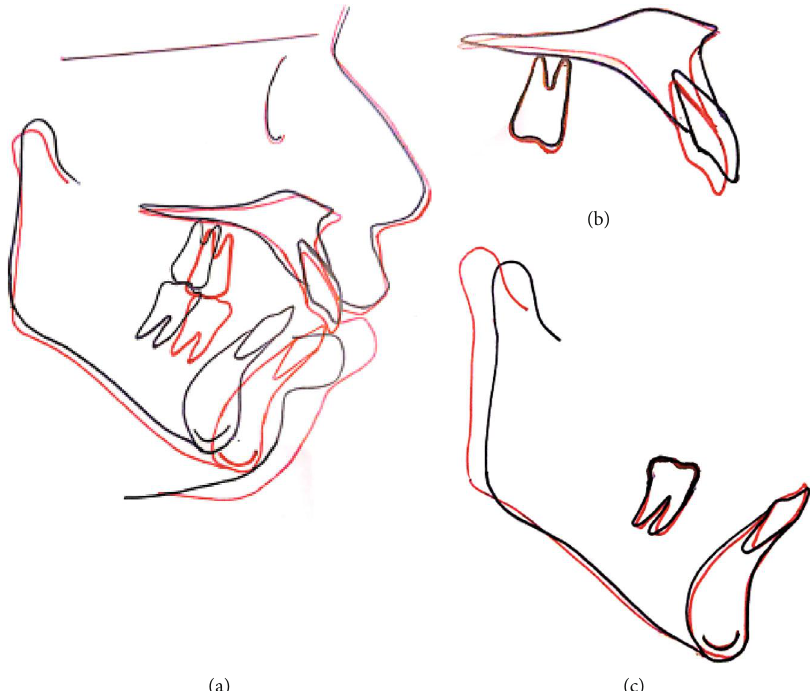
Figure 5: (a) Overall structural superimposition; regional (b) maxillary; and (c) mandibular structural